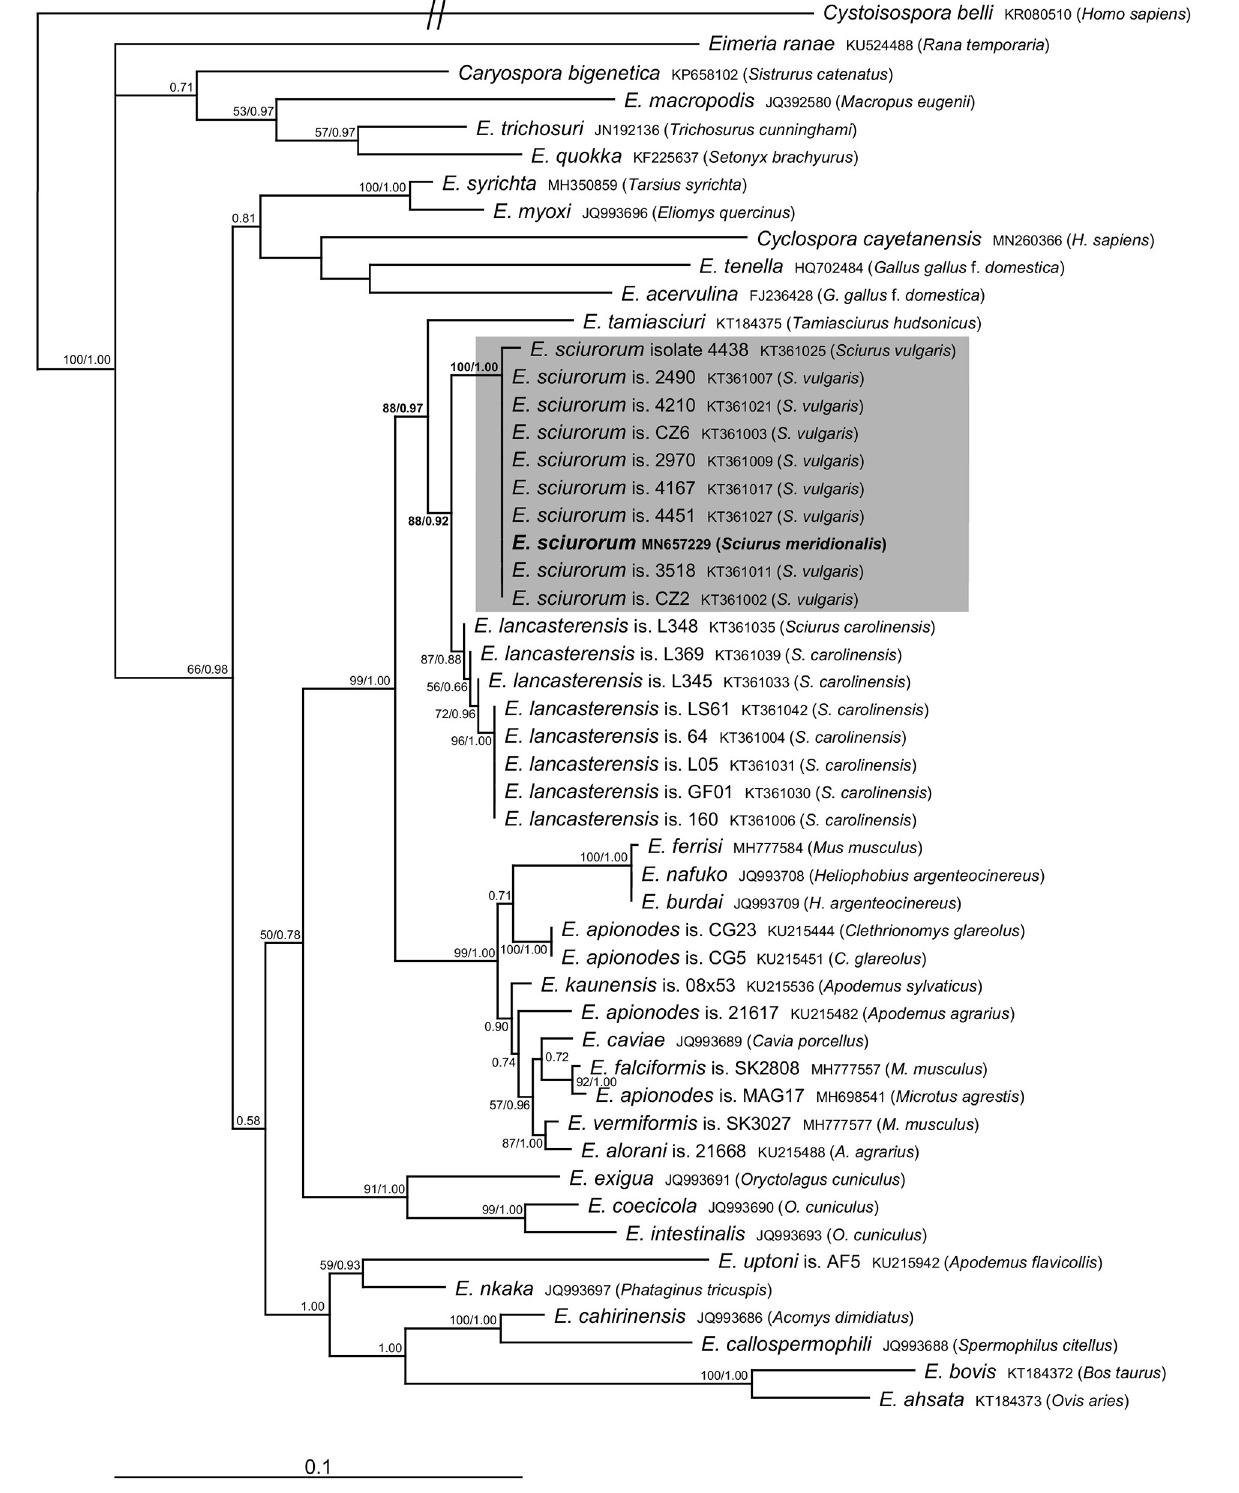
FIGURE 3 | Phylogenetic relationships inferred by the ML analysis of the COI sequences. Numbers at the nodes show bootstrap values derived from ML analysis/posterior probabilities under the BI analysis. Bootstrap supports and posterior probabilities lower than 50% or 0.50, respectively, are not provided. The scale bar represents sequence divergence. Cystoisospora belli is used as an